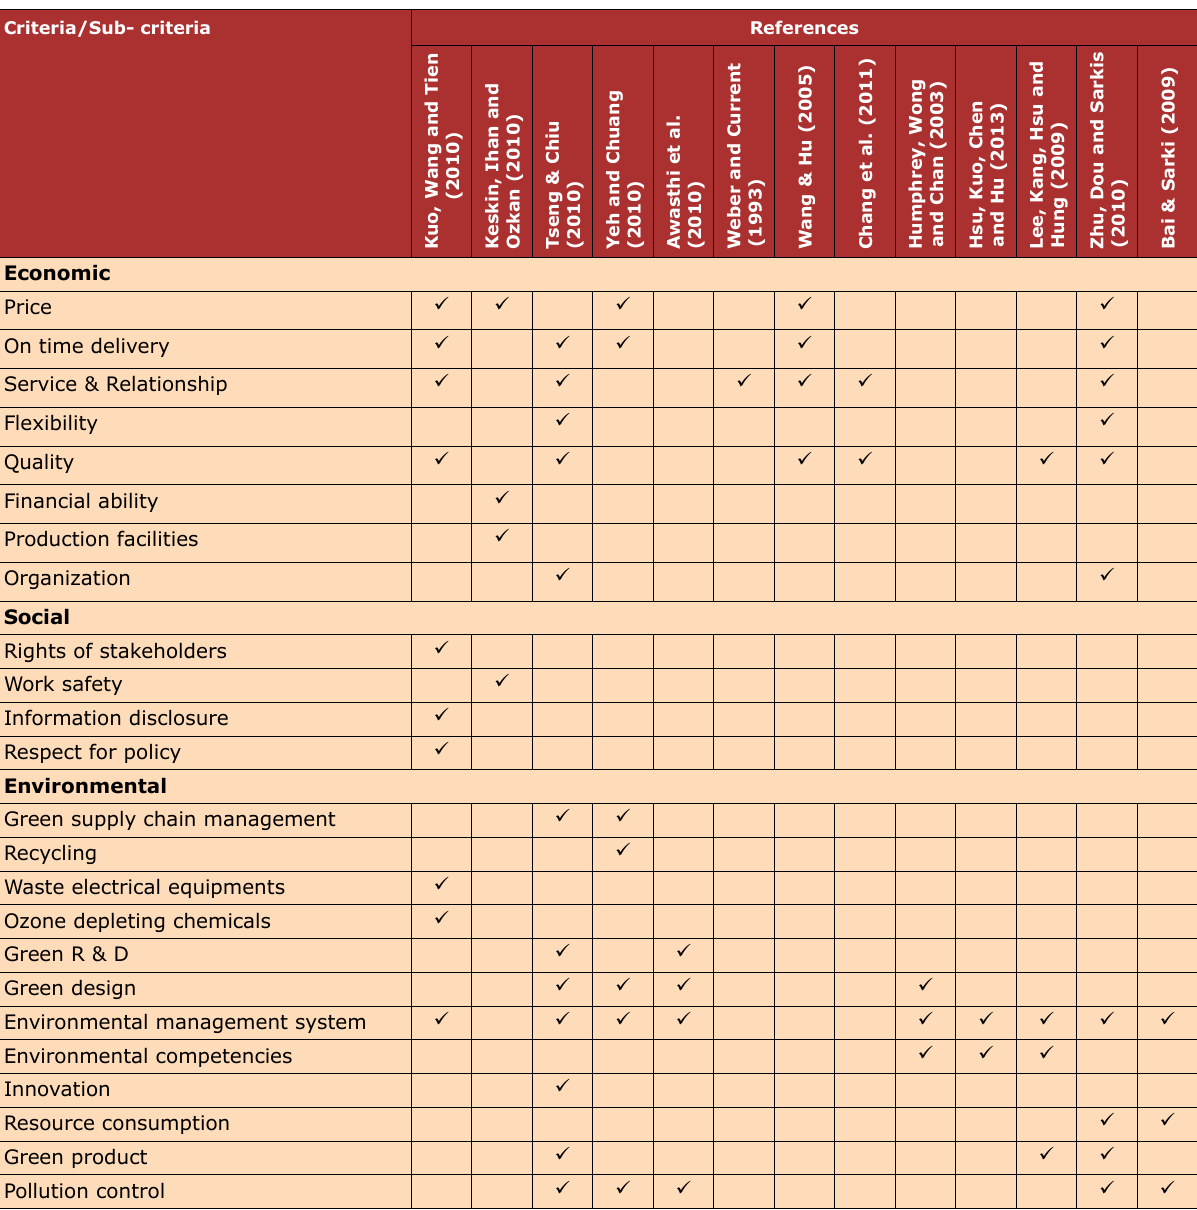
Table 1. Sustainability attributes relevant to supplier